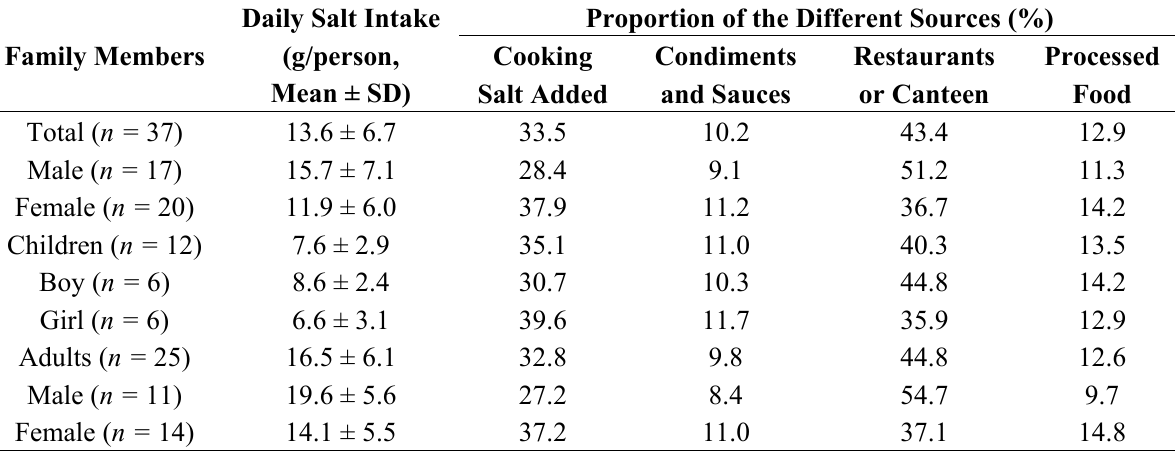
Figure 3. Difference against averages of salt intake estimated by 24-h urine collection and one-week salt estimation methods (Bland-Altman analysis; n = 26). Table 4. Daily salt intake and its sources—One-week salt estimation method ( n =